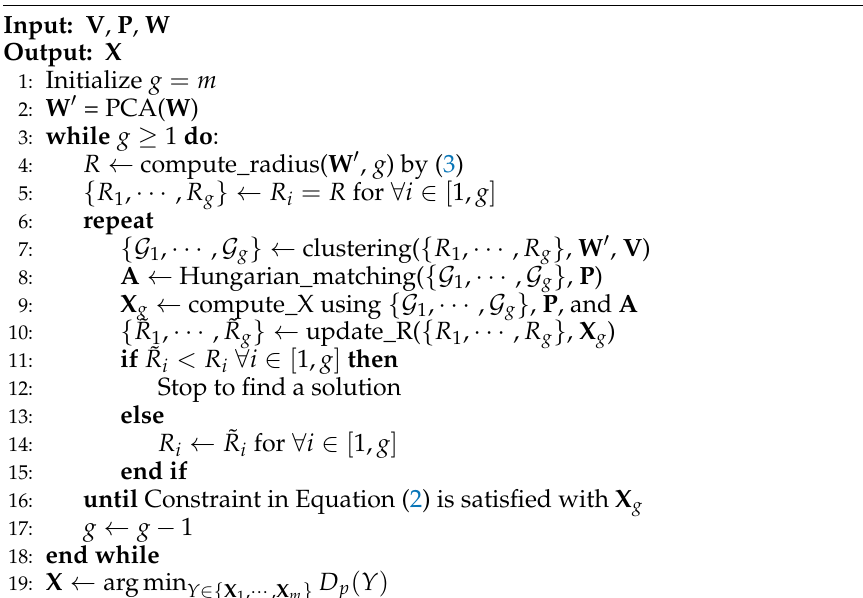
Algorithm 1 Deciding location of